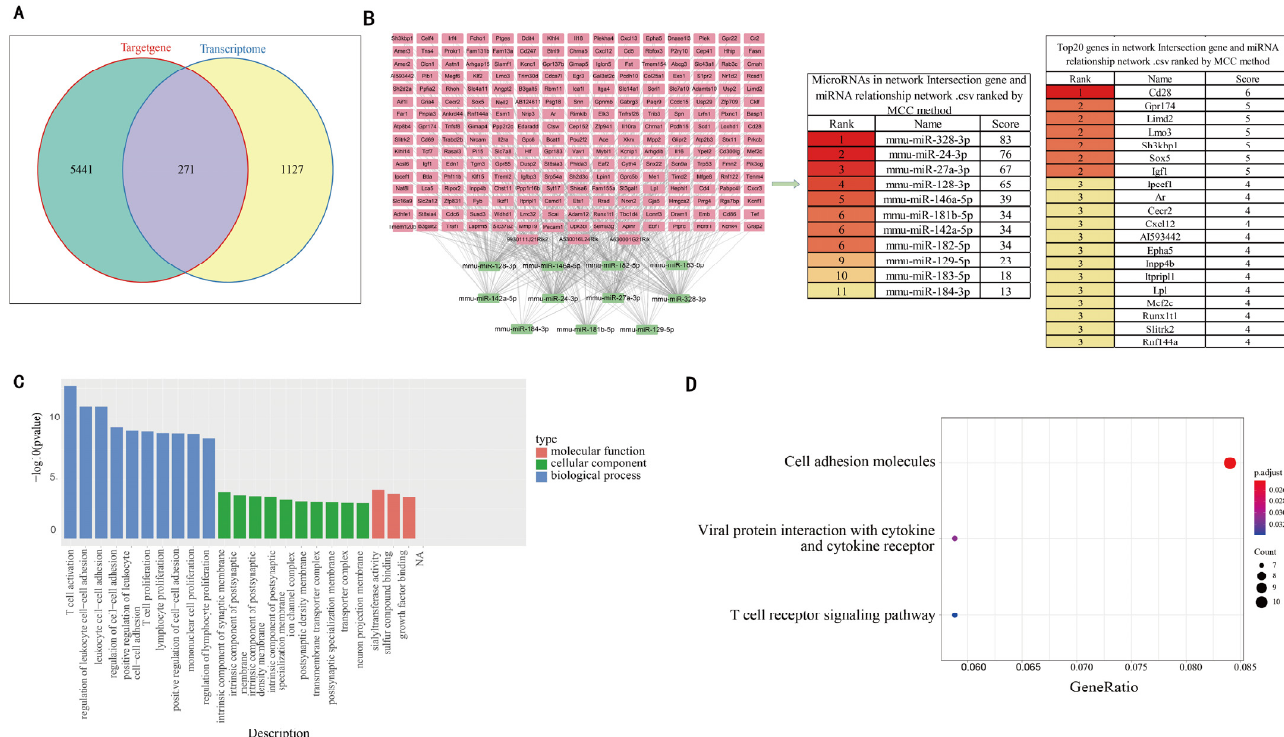
Figure 3. Comparative analysis of DEgenes and the predicted target genes of 11 DEmiRNAs. ( A ) The intersection between DEgenes and the predicted target genes of 11 DEmiRNAs. ( B ) Correlation analysis between 271 common genes and 11 DEmiRNAs identified 243 negatively correlated genes. The miRNA–mRNA relationship was visualized with Cytoscape 3.9.0, in which the core genes were identified using the Cytohubba plugin. ( C ) GO enrichment of 271 common genes. ( D ) KEGG enrichment of 271 common genes.